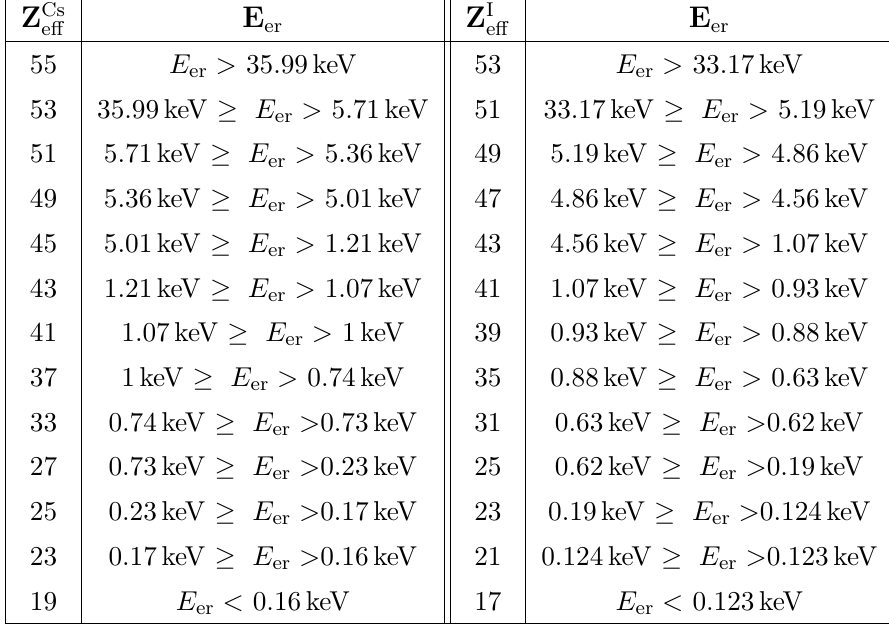
Table 1 . Effective electron charge for Cs and I as a function of the energy deposition E er [72].